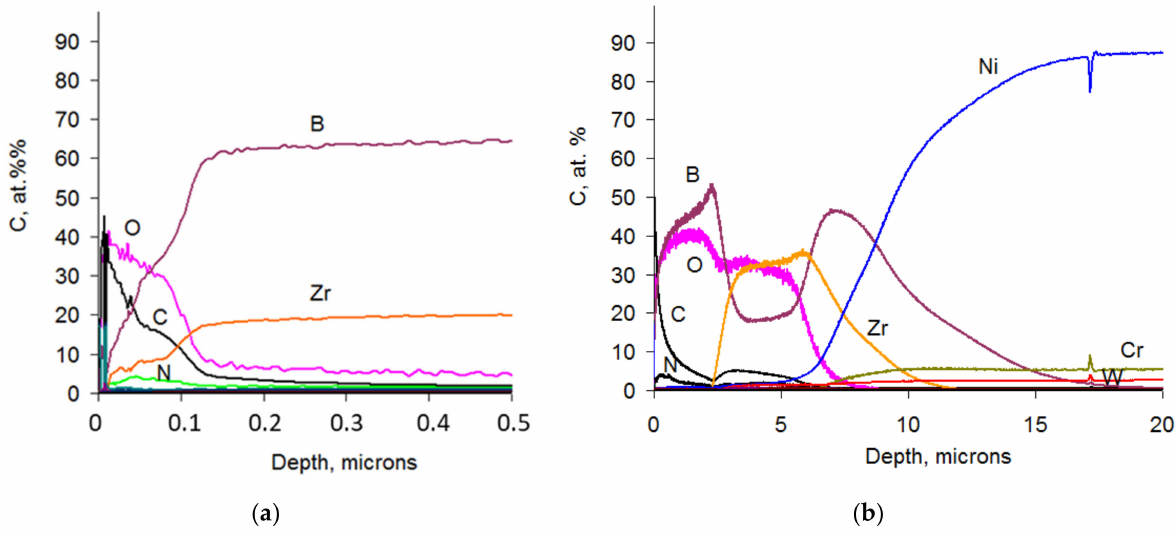
Figure 10. Depth-wise elemental profiles for coating 1 (100%Ar) after annealing in air at 600 ◦ C ( a ) and 800 ◦ C ( b